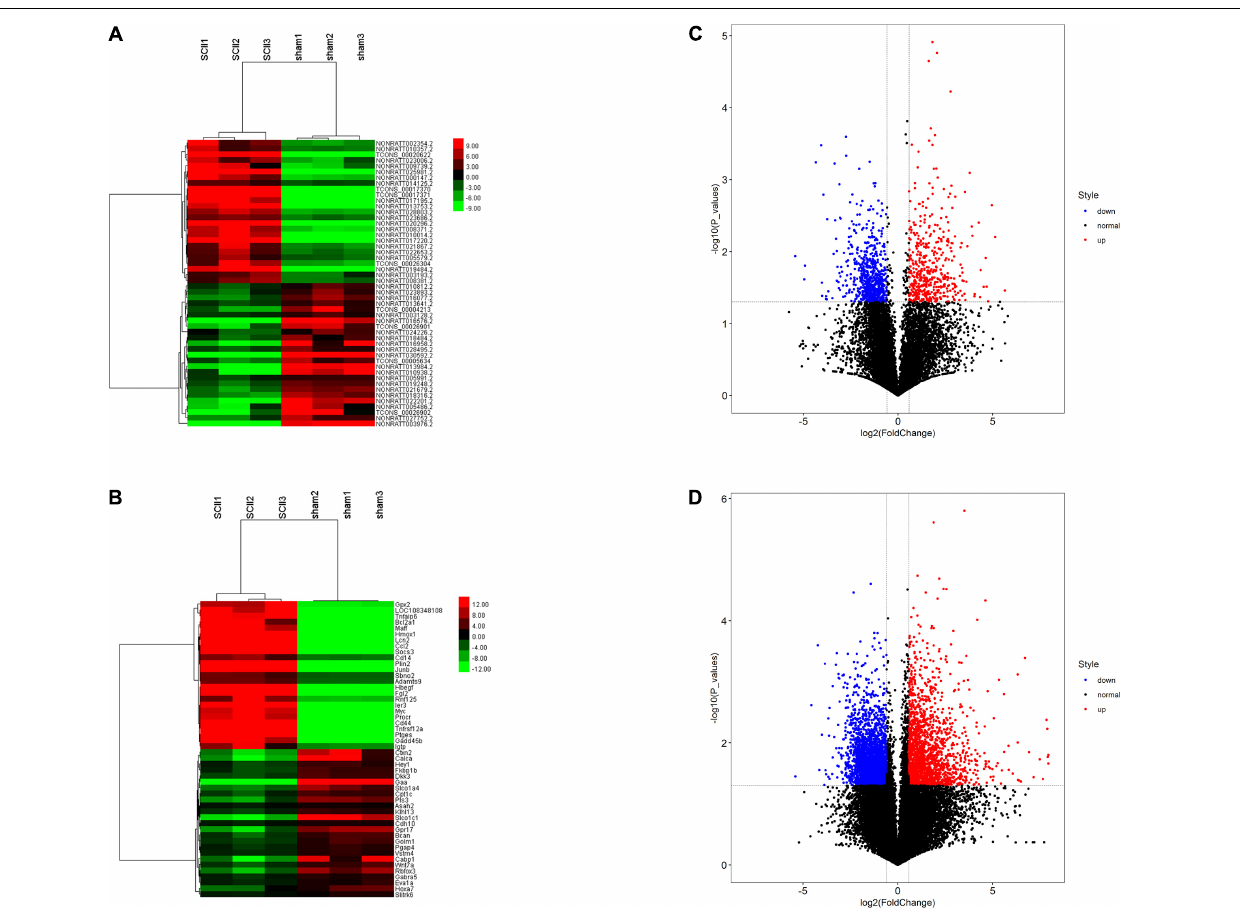
FIGURE 2 | DElncRNAs and DEmRNAs in SCII and sham group. Heatmap and hierarchical clustering of the top 25 upregulated and down regulated DElncRNAs (A) and DEmRNAs (B) . Red indicates that the differentially expressed lncRNAs or DEmRNAs has a high expression value and green indicates that a differentially expressed gene has a low expression value. Volcano plot of 1373 DElncRNAs (C) and 4813 DEmRNAs (D) in SCII. The red and blue points symbolize the upregulated and downregulated DElncRNAs and DEmRNAs with statistical significance (| FC| > 1.5, p <